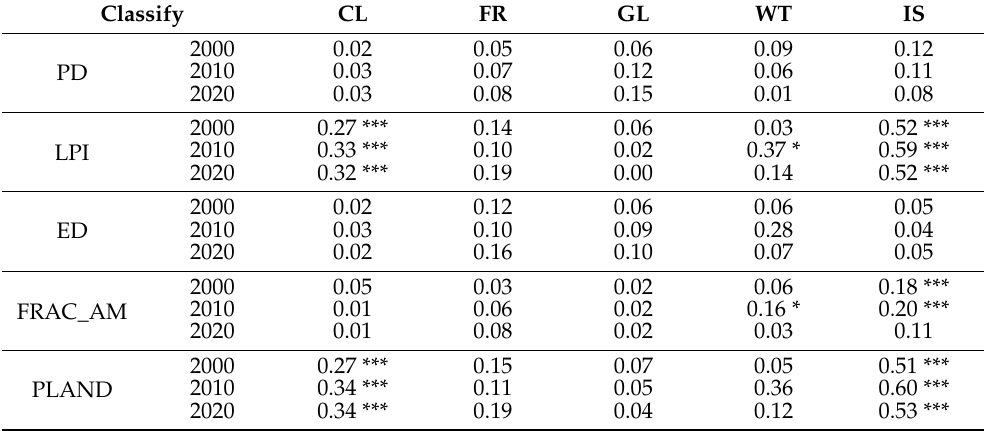
Table 6. Results of the class-level factor detector.